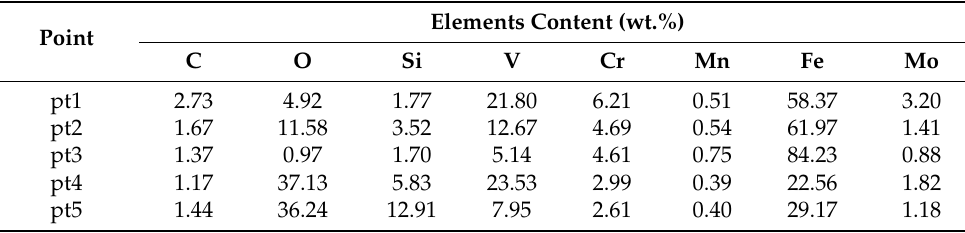
Table 7. EDS results of Fe-Cr-C-V coating (25.4 mm) tested with #50 sand and 48